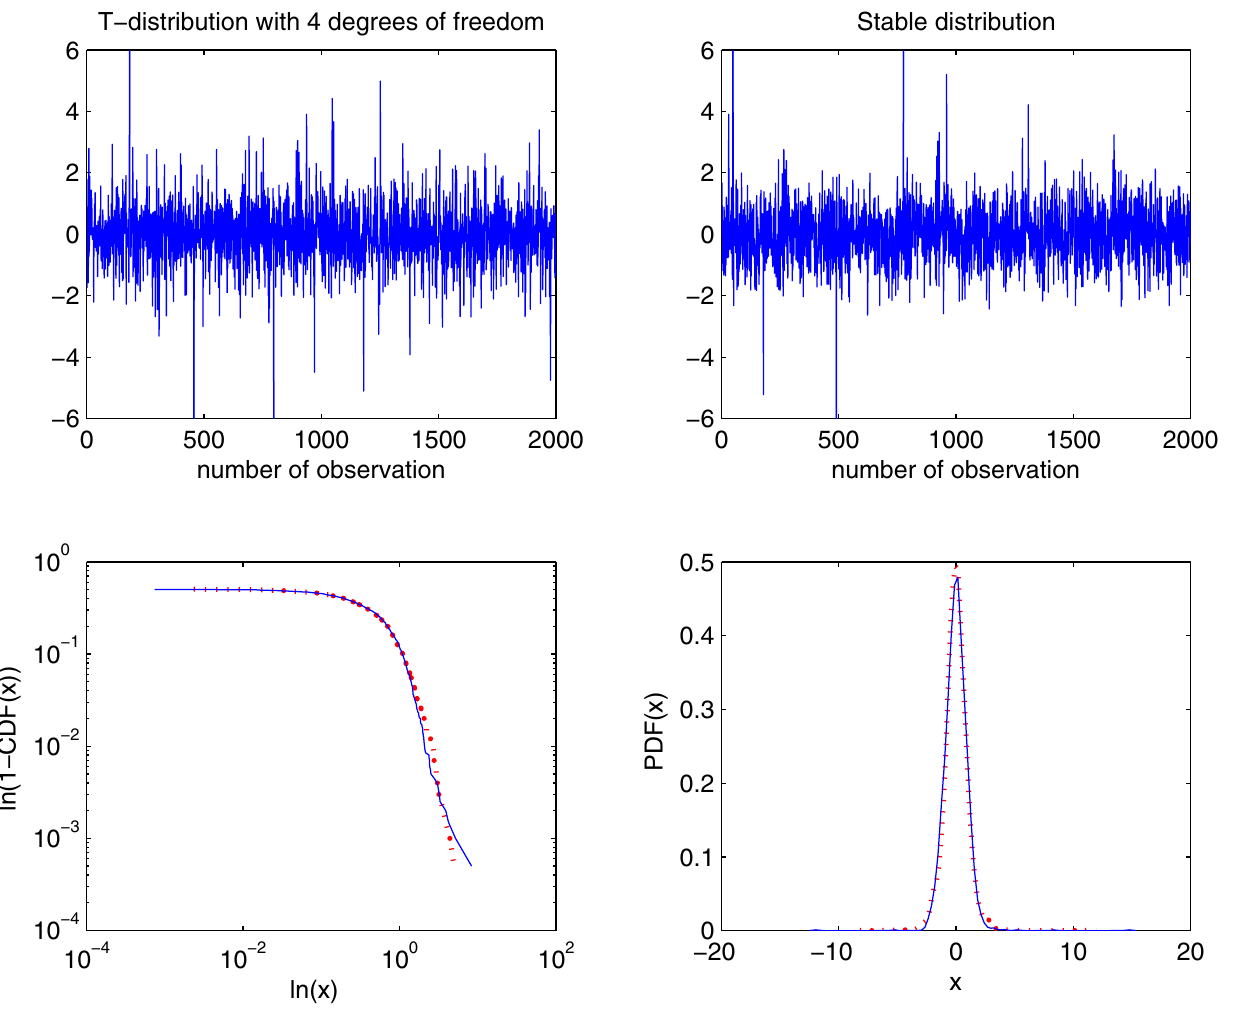
Fig 7. Simulated samples from the Student ’ s t distribution with 4 degrees of freedom (top left panel) and stable distribution with α = 1.85, σ = 0.77, β = 0.15, and μ = 0.01 (top right panel), and their empirical tails in log-log scale (bottom left panel) and PDFs (bottom right